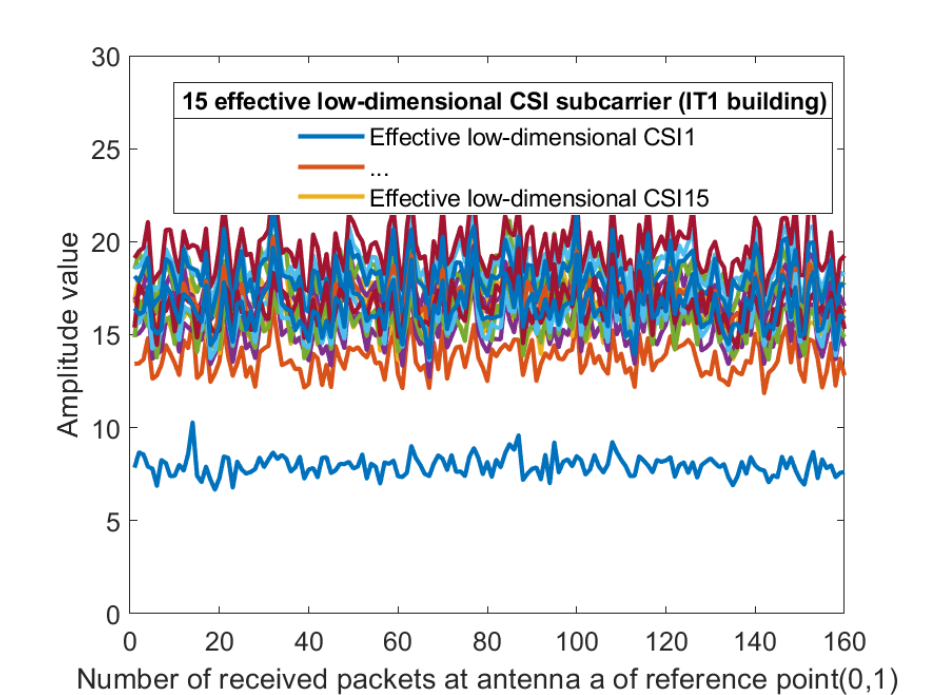
Figure 10. The amplitude of the effective CSI sub-carriers on antenna a at reference point (0,1) of AP1 in the corridor of IT1 building.